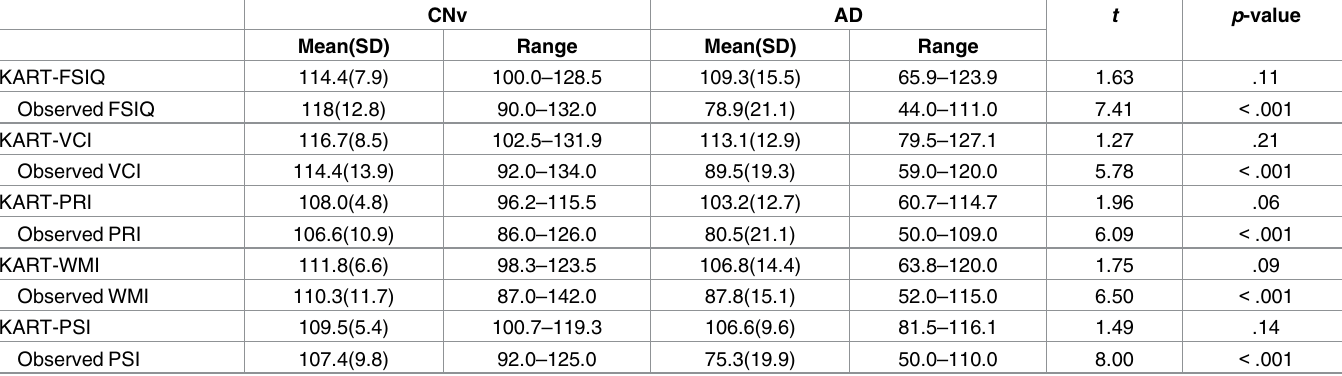
Table 3. Differencesof K-WAIS-IV observed IQs and KART-predicted IQs between CNv and AD